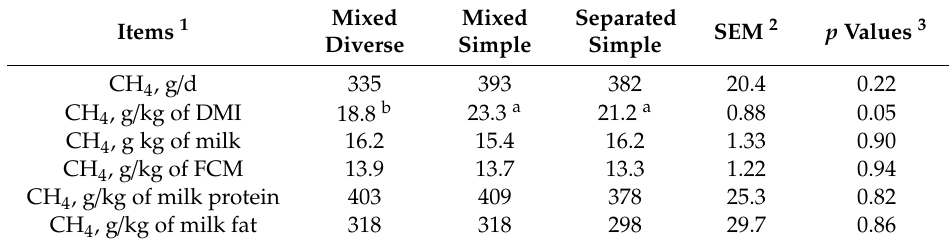
Table 8. E ff ect of pasture type on methane emissions and their relationship to animal